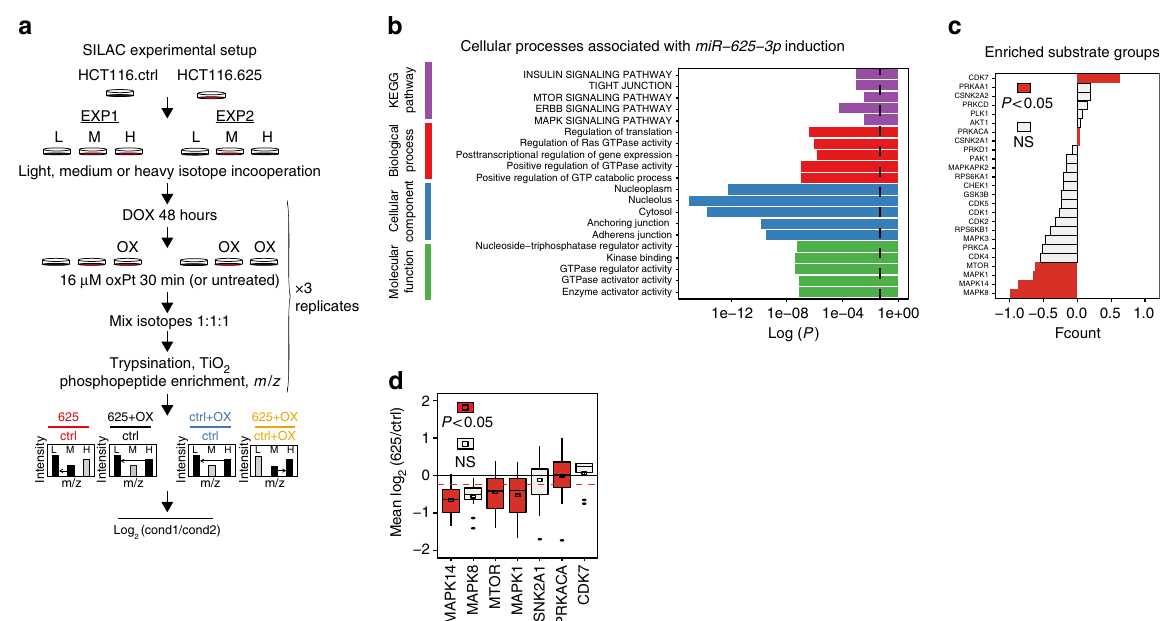
Figure 6 | Decreased MAPK signalling is associated with miR-625-3p induction. ( a ) Phosphopeptide-enriched SILAC mass-spectrometry analysis was performed on HCT116.ctrl and HCT116.625 cells in two experimental setups done in parallel (‘EXP1’ and ‘EXP2’) each involving three experimental conditions labelled with light (‘L’), medium (‘M’) or heavy (‘H’) isotopes. Each experimental condition was done in triplicate. Four data sets were generated by calculating the mean log 2 peptide intensity ratios from triplicate experiments for the following conditions: (i) HCT116.625/HCT116.ctrl (red), (ii) oxPt-treated HCT116.625/HCT116.ctrl (black), (iii) oxPt-treated HCT116.ctrl/HCT116.ctrl (blue) and (iv) oxPt-treated